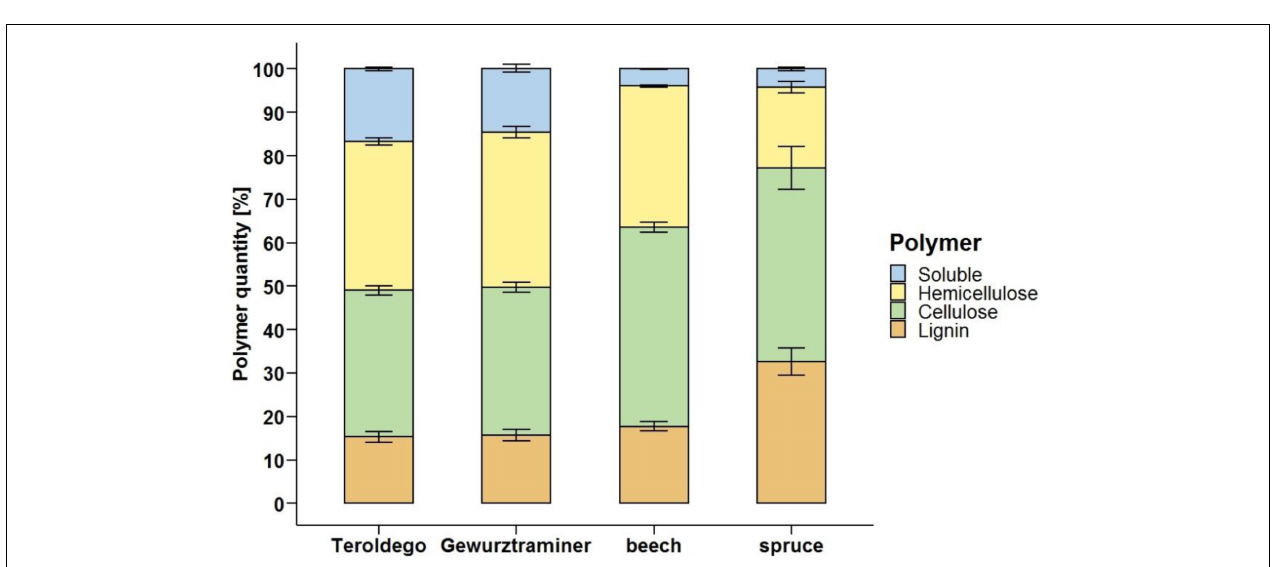
FIGURE 5 | Grapevine wood weight loss after fungal degradation. Two grapevine varieties (cv. Teroldego and cv. Gewurztraminer) were compared. Weight loss is shown as the difference between wood blocks weight before and after degradation. For degradation, wood blocks were inoculated with 2 strains of Fmed (LR124 and PHCO36) and degraded at 28 ◦ C in the dark for 30 and 90 days. Error bars on histograms represent the standard error of the mean.